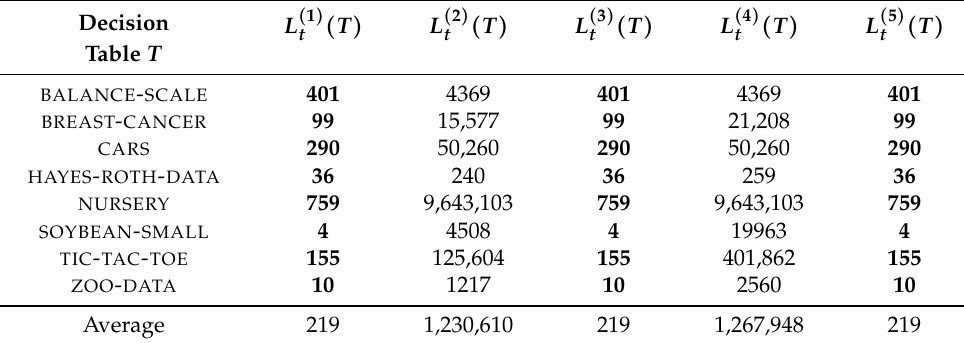
Table 6. Experimental results for decision tables from Reference [20]—number of realizable terminal nodes.